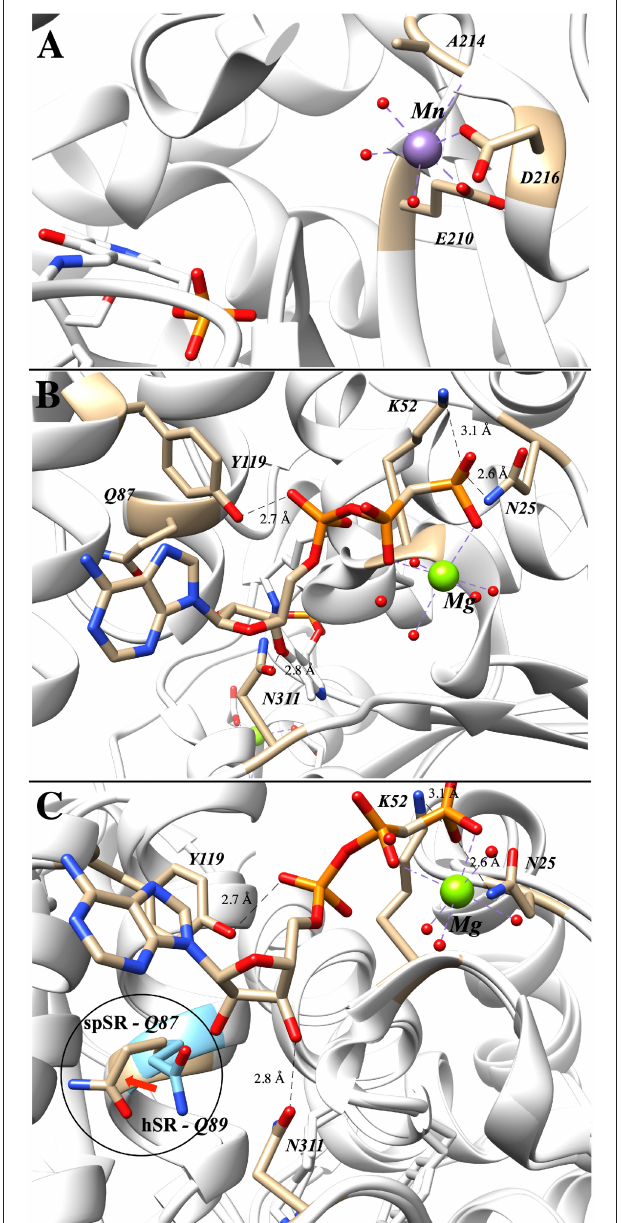
FIGURE 4 | (A) Mn 2 + occupying the metal binding site in hSR; both E210 and D216 are within 2.1 Å of the divalent metal (3L6B). (B) Binding of the second ATP–associated metal from the AMP-PCP-bound structure of S. pombe SR (1WTC). (C) Overlay of human (blue) and S. pombe (tan) SR highlighting the movement of Q89 upon ATP-binding (Q89 in hSR and Q87 in spSR).